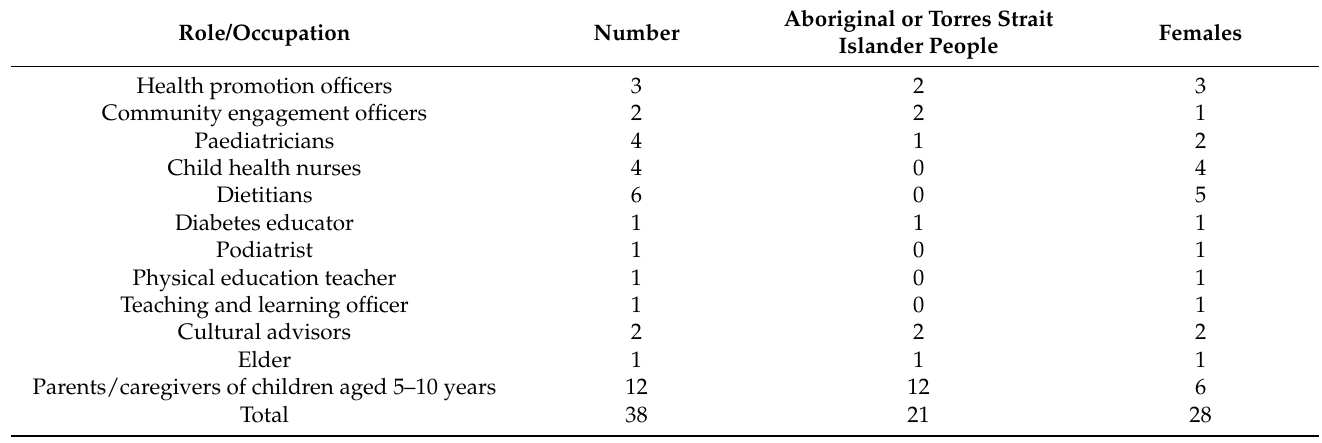
Table 3. Description of individuals who participated in program